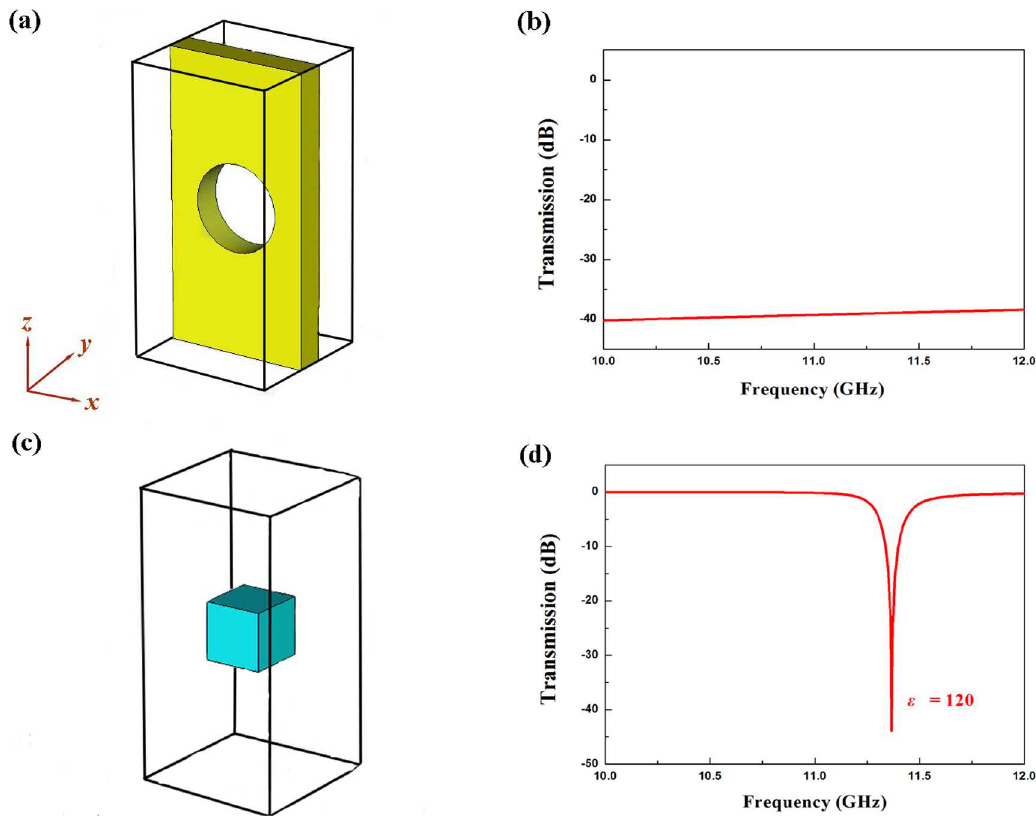
Fig 2. Schematic diagram and the simulated transmission spectrum. (A) Schematic diagram and (B) simulated transmission spectrum of metallic apertureunit cell. (C) Schematic diagram and (D) simulatedtransmissionspectrum of single dielectric